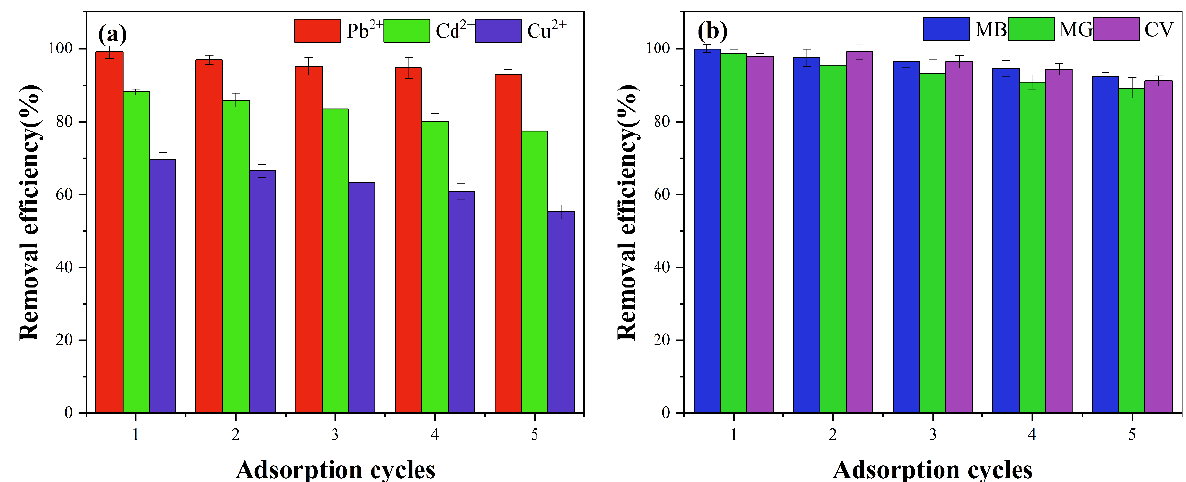
Figure 8. Removal efficiency of FSAH ( a , b ) adsorption of heavy metals and dyes after 5 recycles.